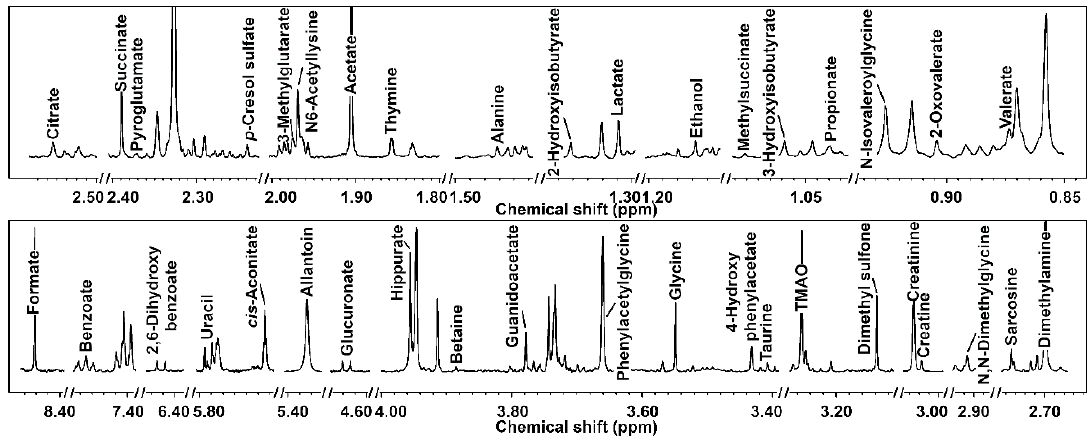
Figure 1. Portions of 1 H-NMR spectra, representative of all the spectra obtained in this study. Each molecule’s name appears over the NMR peak used for its quantification. To ease the visual inspection of each portion, a di ff erent spectrum with a convenient signal-to-noise ratio has been